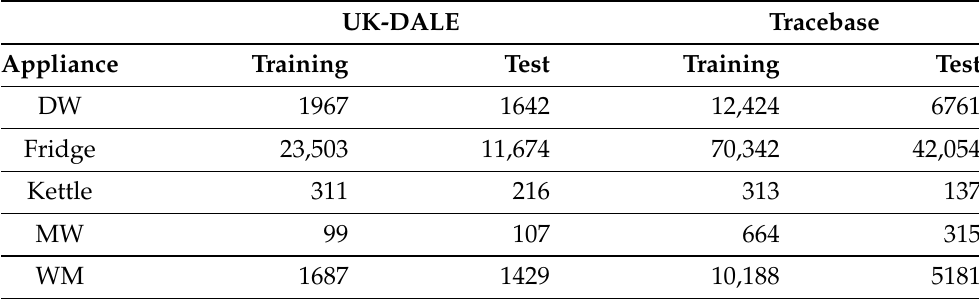
Table 1. The number of events in the training and test datasets.